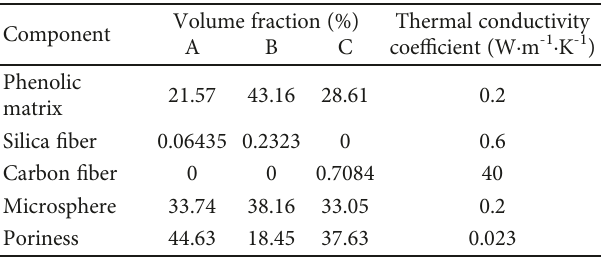
Table 2: Each component ’ s parameters of the ablation material ’ s carbonized